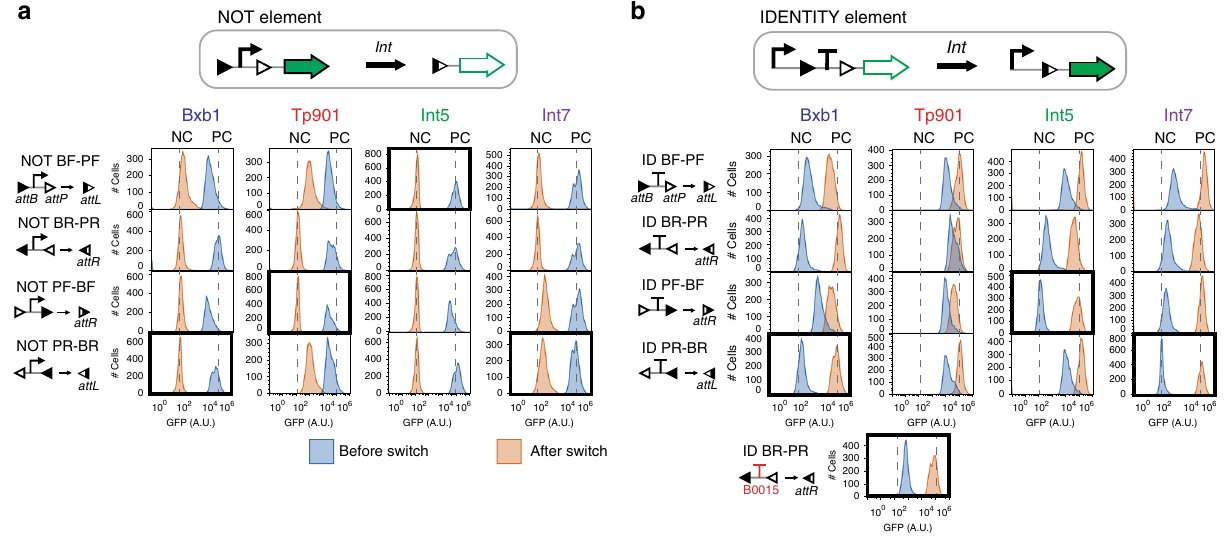
Fig. 2 Identi fi cation of well-operating logic elements form a library of NOT and IDENTITY elements. NOT and IDENTITY elements responding to four integrases (Bxb1, TP901-1, Int5, Int7) were characterized. For each element, four different designs are possible (BF-PF, BR-PR, PF-BF, PR-BR). We